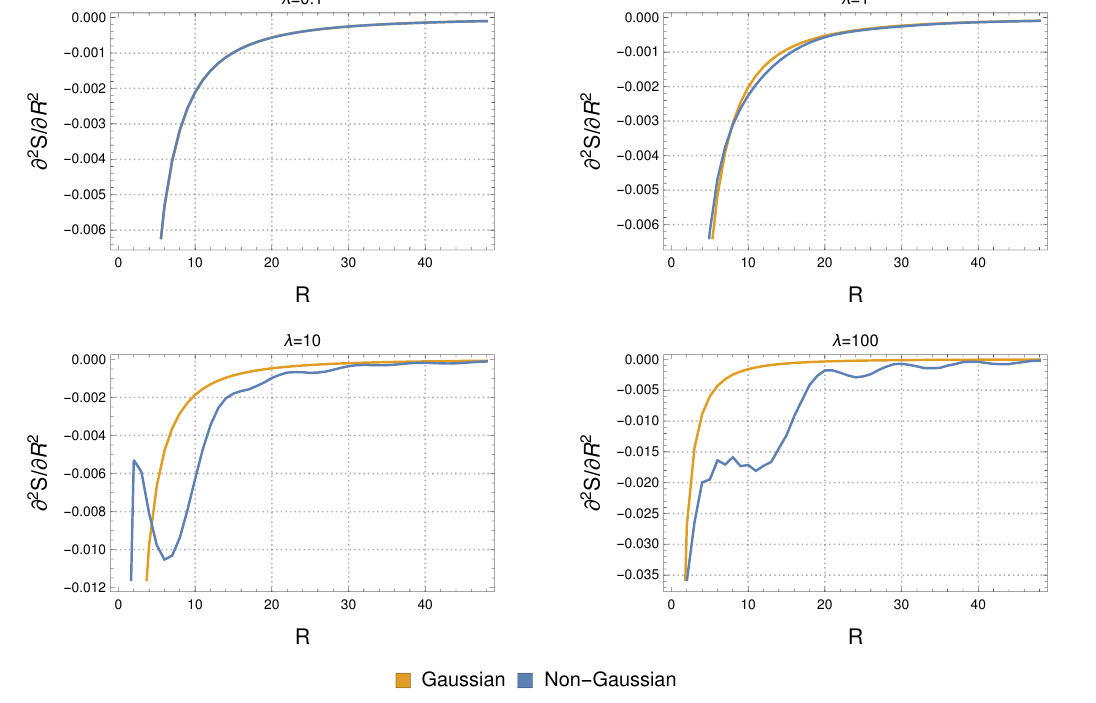
Figure 3 . Concavity of the entanglement entropy for the Gaussian (orange) and non-Gaussian (blue) states that minimize the expectation value of the Hamiltonian (4.1) for different values of λ